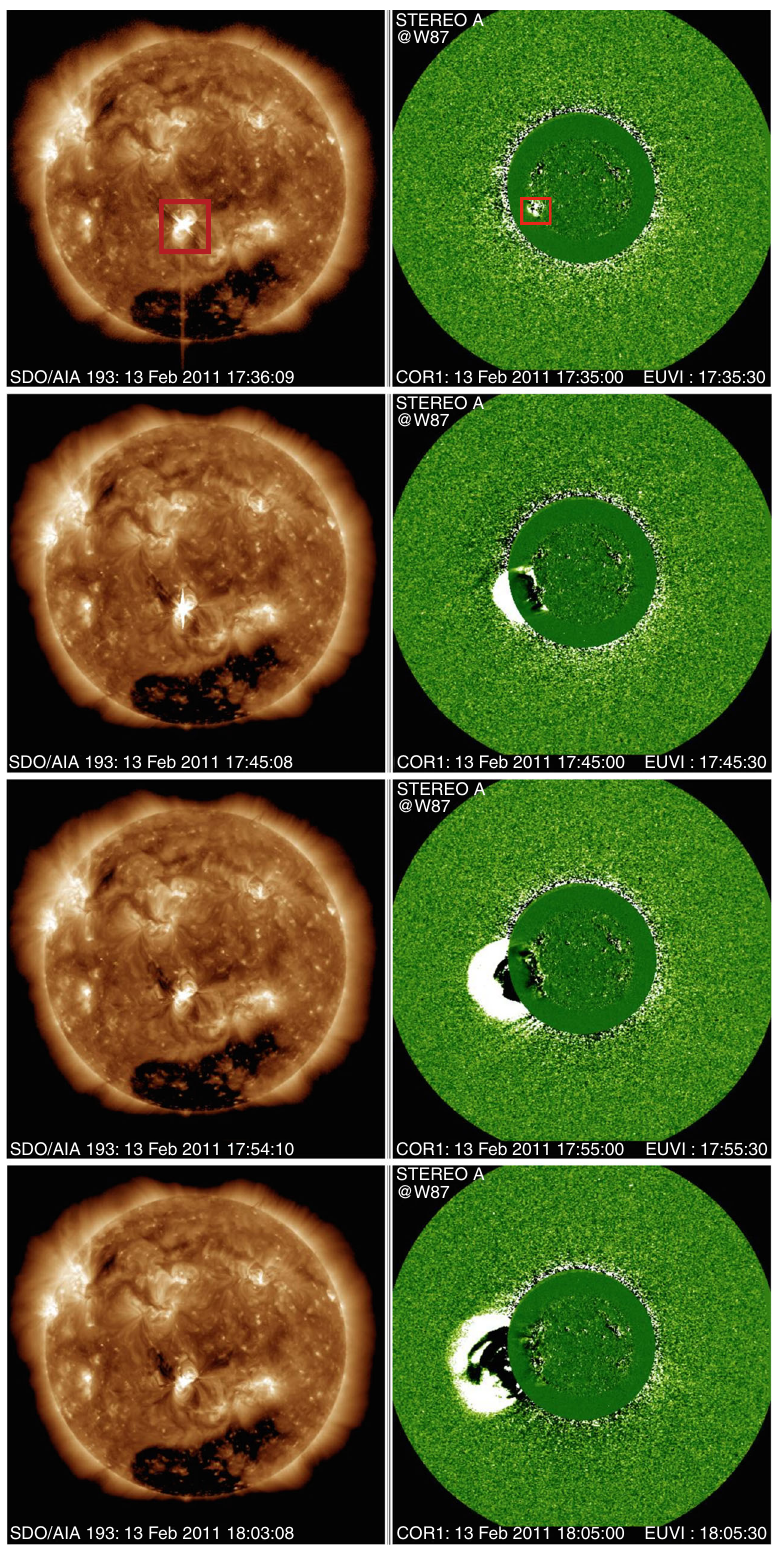
Fig. 2 CME observation associated with the M6.6-class solar fl are on 13 February 2011. The left panels show the temporal evolution of the whole sun observed with EUV 193 Å taken from SDO/AIA. The M6.6 class fl are was observed in the red square. CME is clearly observed by STEREO-A, associated with the M6.6 class fl are. These fi gures are courtesy from Dr. S. Yashiro